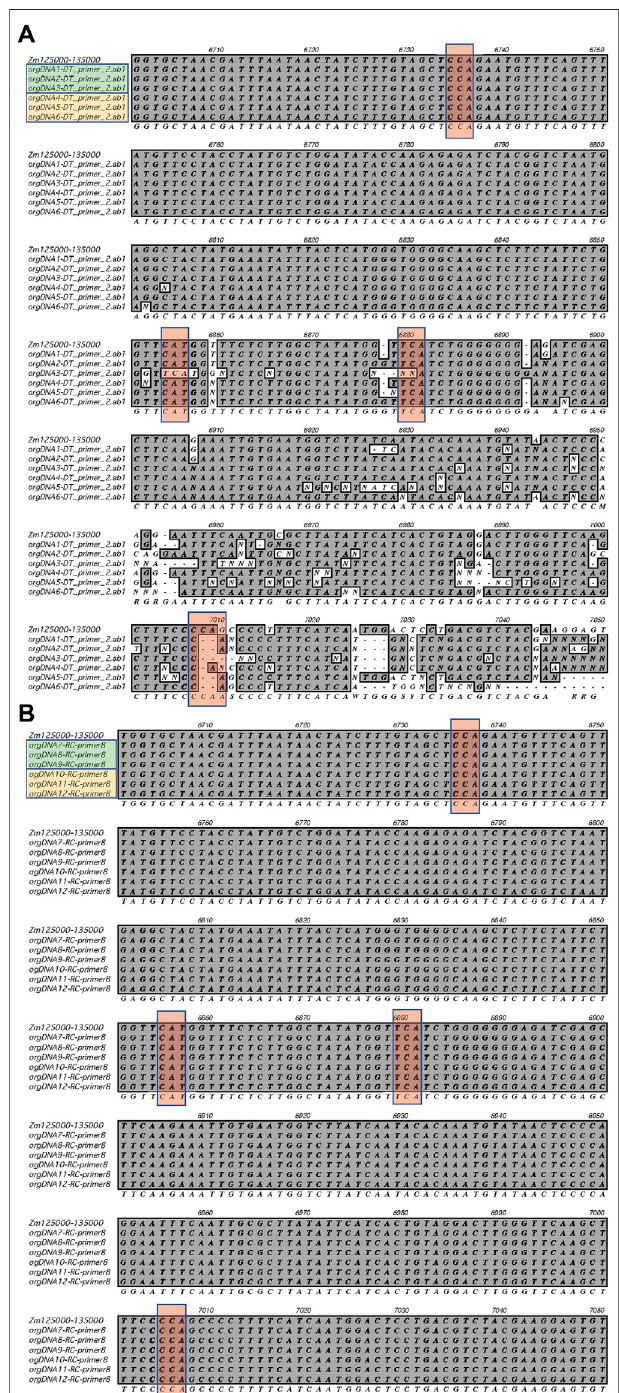
FIGURE 4 | RNA editing sites within the ndhB gene. Sanger sequencing was performedusingptDNAobtainedfromL1_lightandStalk_lighttissues. (A) Thesequences obtained using forward primer ndhB-F2 are shown. (B) The sequences obtained using the reverse primer ndhB-R8 are shown (reverse compliment was used for alignment).Rowoneshowsthereferencesequenceforthe ndhB inIRa(+strand);Rows two to four show sequences from three samples of L1_light (green box); Rows fi ve to sevenshowsequencesfromthreesamplesofStalk_light(yellowbox);Roweightshows the consensus sequence. The conserved RNA editing sites are shown in red boxes.